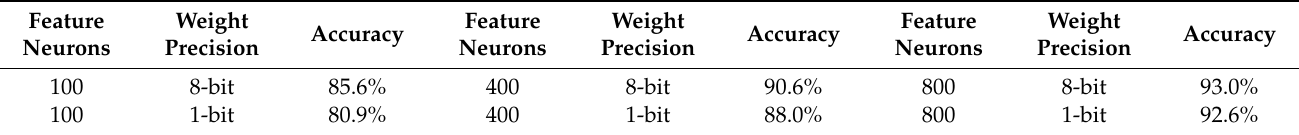
Table 3. Impact of weight precision on accuracy.